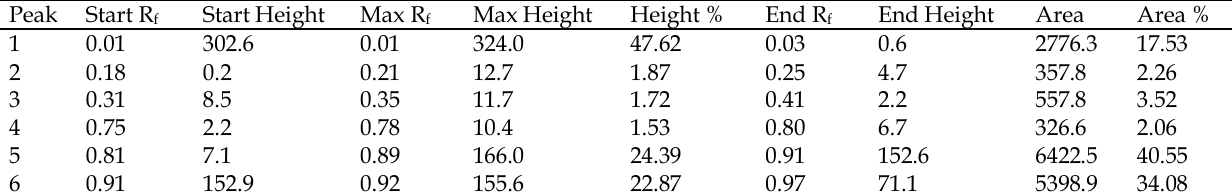
Table 10a. R f value, No. of Peaks, peak area and height of hydroalcholic extract of O. tenuiflorum in Toluene: Ethyl acetate at 254 nm.